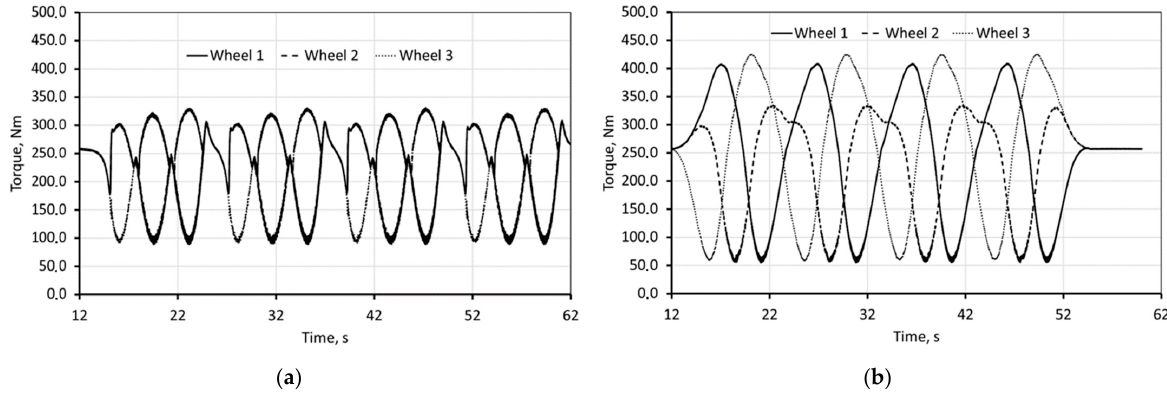
Figure 16. Torque on wheels with nominal pump flow for spool flow divider ( a ) and gear-type flow divider ( b ).